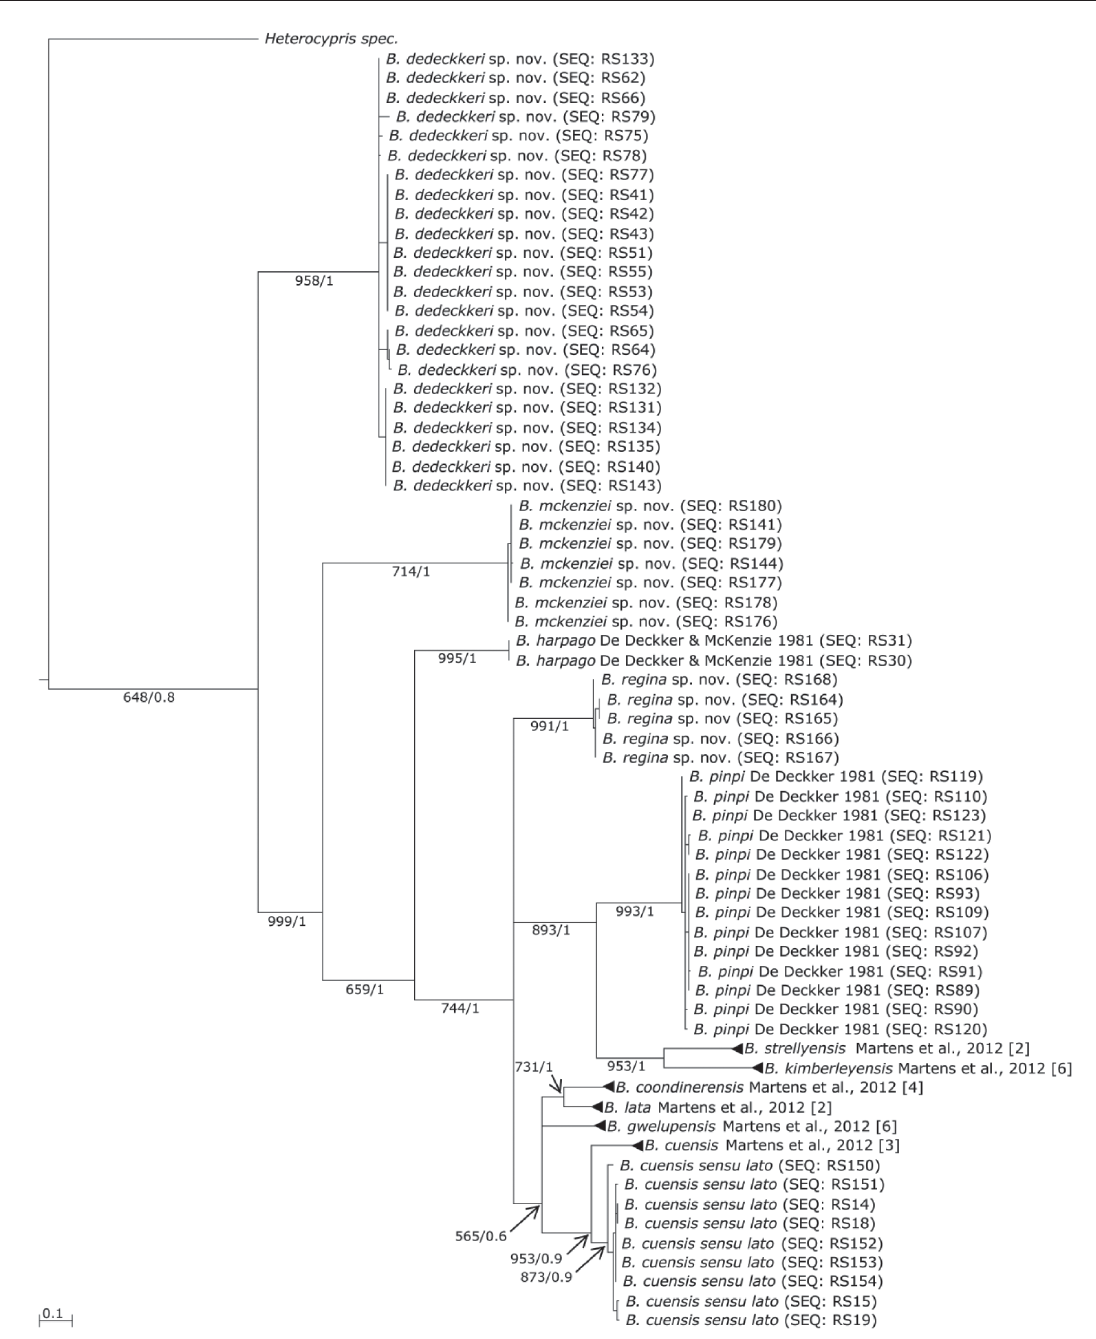
Fig. 2. Phylogenetic tree constructed with 57 novel COI sequences of Bennelongia , 26 published Bennelongia sequences and one Heterocypris spec. as outgroup (sequence names are given in brackets at the end of species names). This tree represents two trees of identical topology inferred by ML and BI. Bootstrap values (for 1000 bootstrap replicates) from ML analyses and Bayesian posterior probabilities (ranging from 0 to 1) are shown for each node (in the format: ‘Bootstrap Support/Posterior Probability’). Branch lengths are proportional to the genetic distance scale at the bottom left. Clades with published sequences have been collapsed; the number of sequences in these clades is included in brackets after the species name. Nodes with less than 50% bootstrap support and a posterior probability of less than 0.5 have been collapsed. The tree shows six strongly supported clades that correspond to the species presented in this